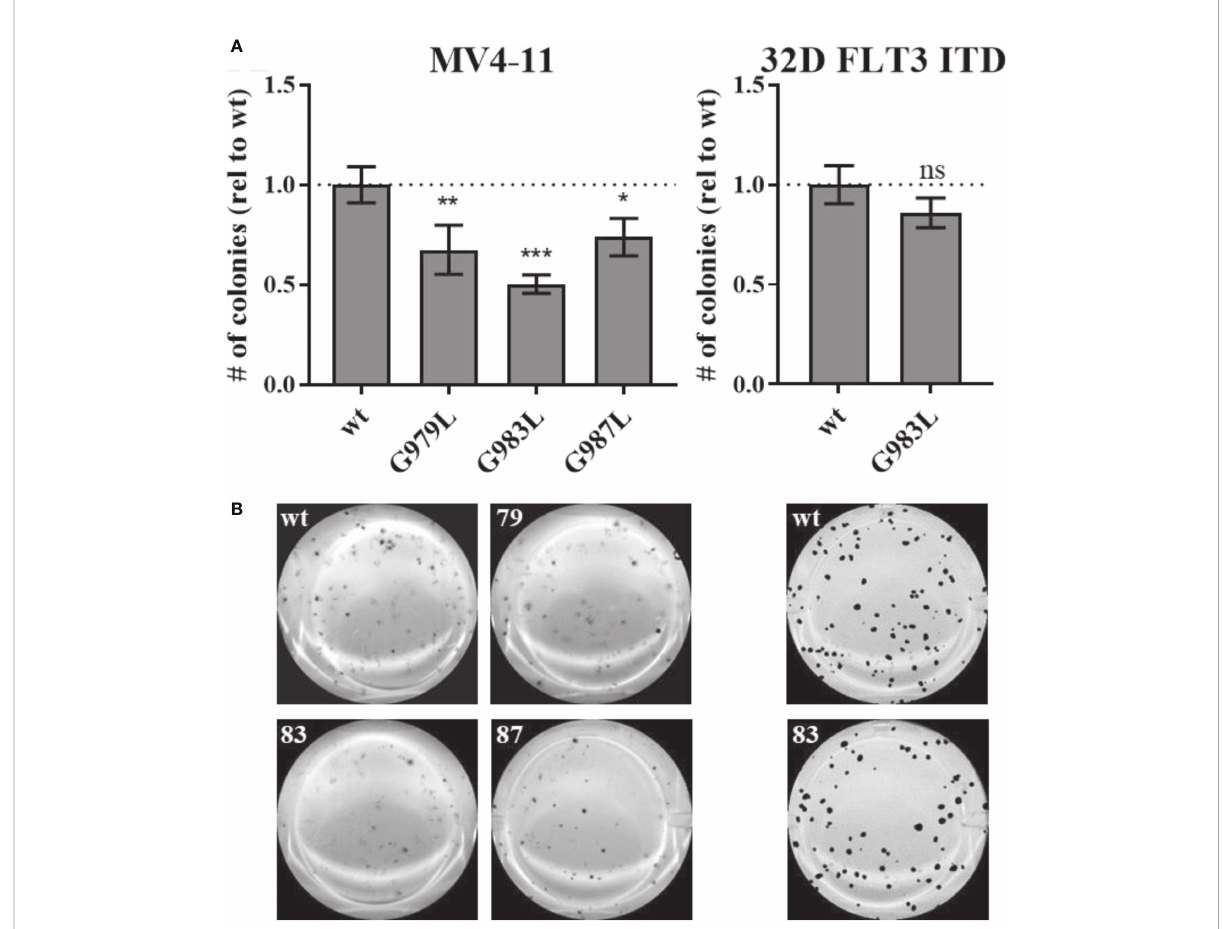
FIGURE 6 Clonal growth of FLT ITD cells expressing TMD mutant PTPRJ proteins. MV4-11 and 32D FLT3 ITD PTPRJ KO cells re-expressing PTPRJ wt, G979L, G983L, or G987L were seeded in triplicates in 1.27% methylcellulose-containing, cytokine-free medium. Colonies were stained with iodonitrotetrazolium chloride after 7 days (32D FLT3 ITD) or 10 days incubation (MV4-11) and quanti fi ed using Image (J) (A) Number (#) of colonies per well relative (rel) to wt is shown. Values are given as mean ± standard deviation, n = 3. Statistics for MV4-11: one-way ANOVA and Dunnett ’ s multiple comparisons test; *p ≤ 0.05; **p ≤ 0.01; ***p ≤ 0.001 compared to respective wt (ns; not signi fi cant). Statistics for 32D FLT3 ITD: unpaired two-tailed t-test; * p ≤ 0.05. (B) Representative images of whole wells are shown. 79 – G979L; 83 – G983L; 87 –